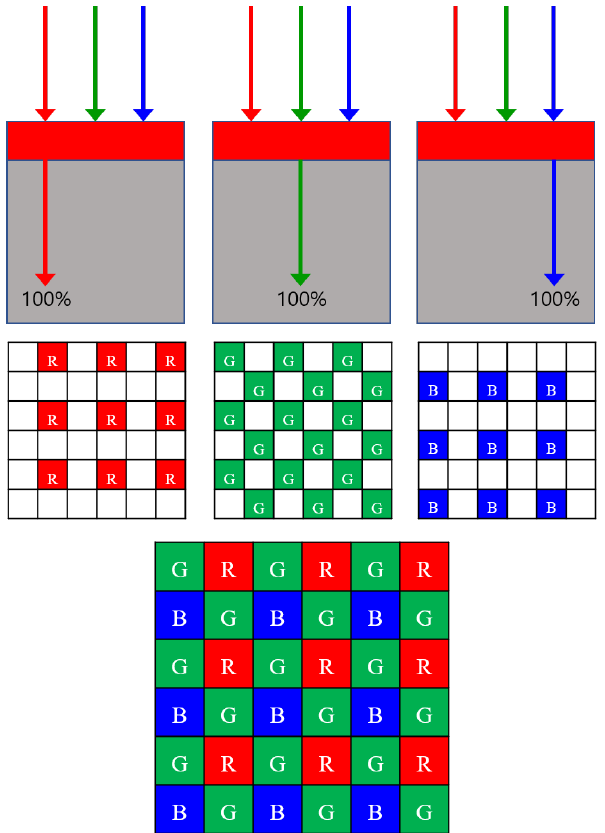
Figure 1. A 6 × 6 partial cut of the Bayer color filter array. R: Red pixels, G: Green pixels, B: Blue